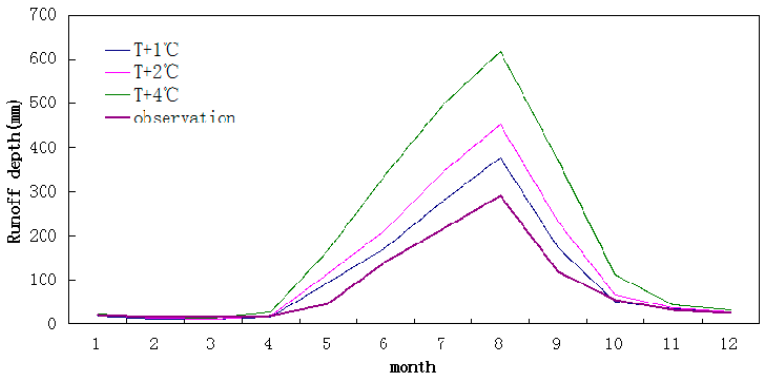
Figure 12. Sensitivity of runoff under various temperature variations relative to the period 2007–2011. Table 5. Change of runoff under various changes of temperature.